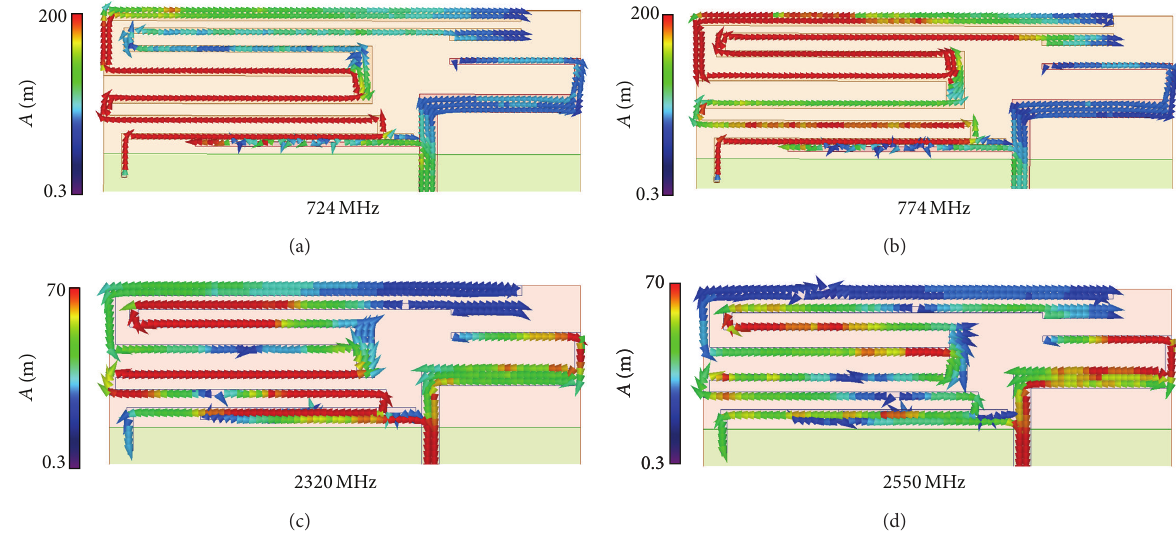
Figure 4: Simulated current distribution of the proposed miniaturized